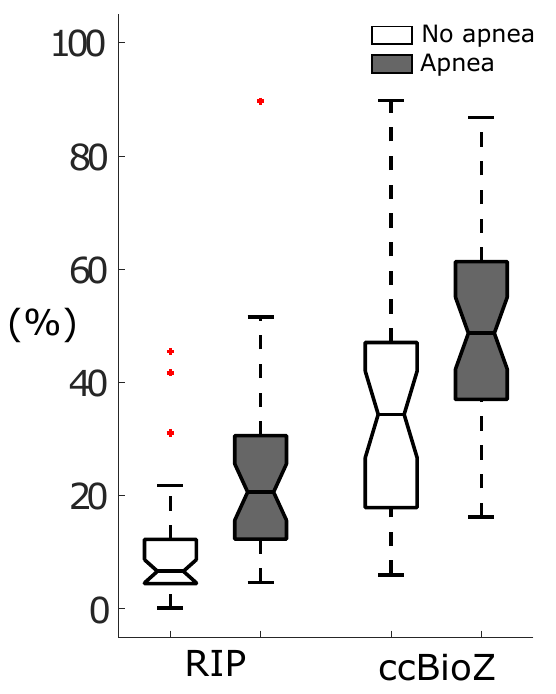
Figure 6. The number of false wake predictions per total amount of true wake epochs after sleep– wake classification on the full ccBioZ recordings. A distinction was made between epochs without (white) and with apneas